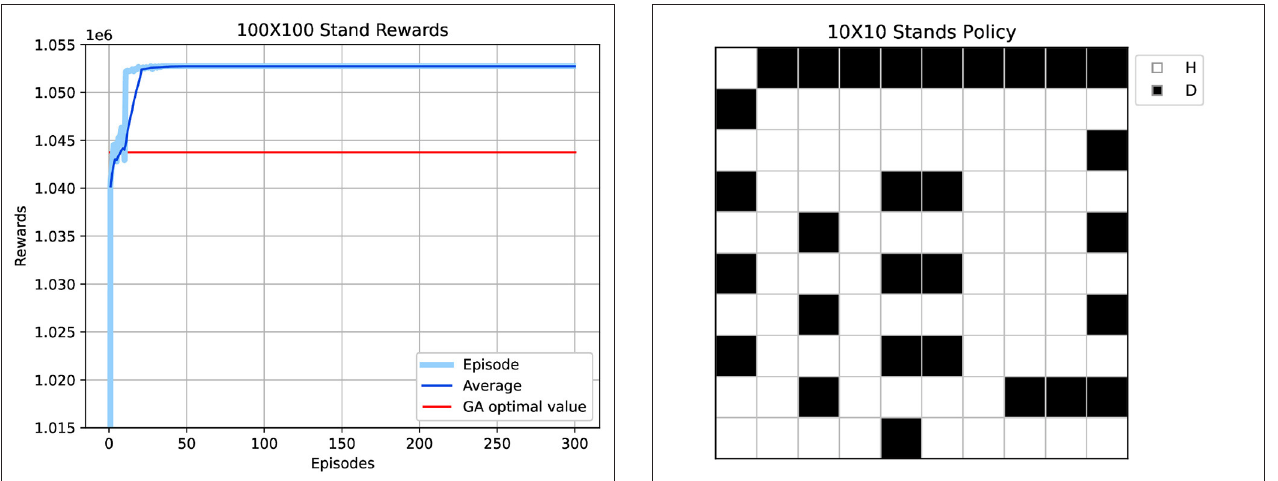
TABLE 3 | Summary of DRL performance compared to GA for Cases 2 and 3.